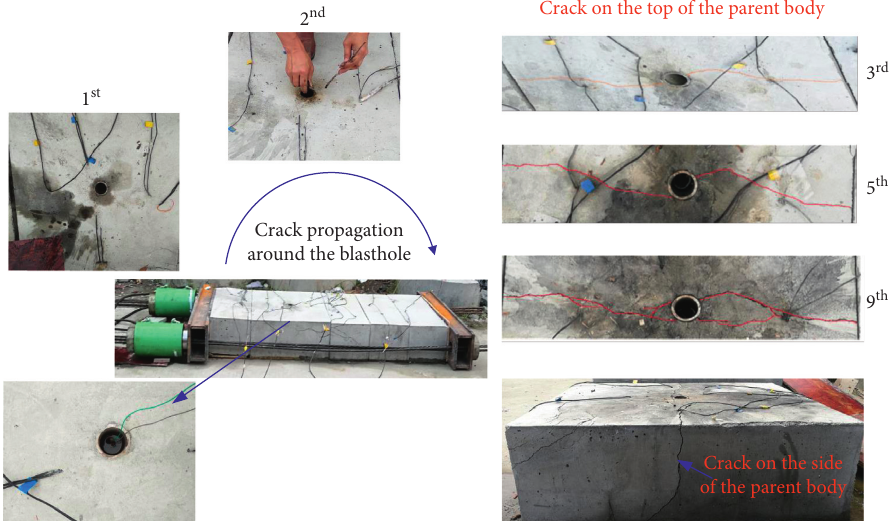
Figure 7: Crack propagation around the blast hole on the top and side of the parent body in Model 2 after nine blasts with a delay detonator and explosive.